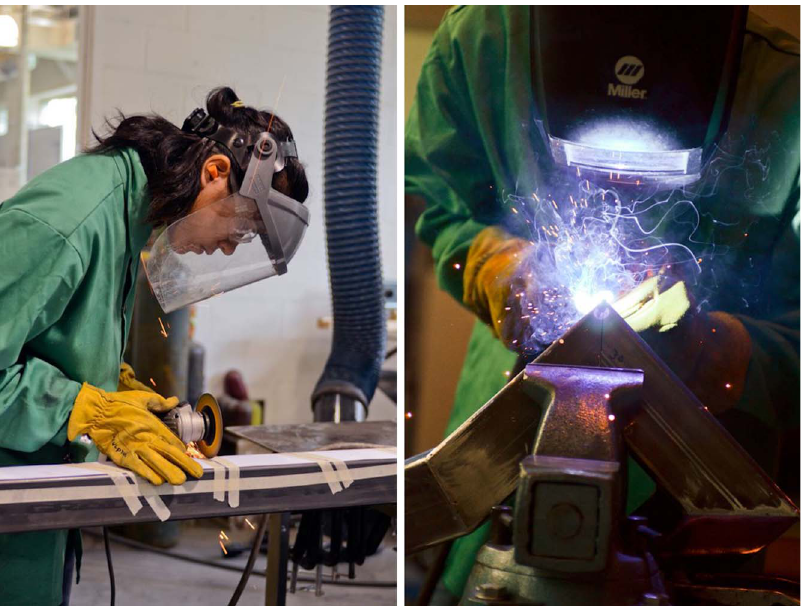
Figure 3. Undergraduates helped design and fabricate steel protein sculptures using published scientific data. (Photos by Larry